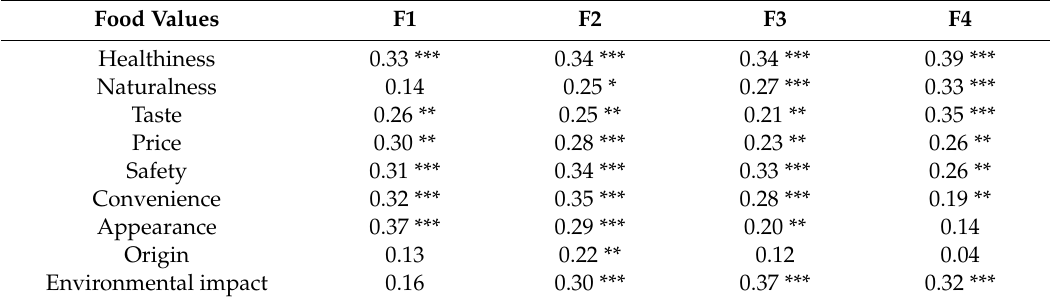
Table 6. Pairwise correlation index values for “informed”